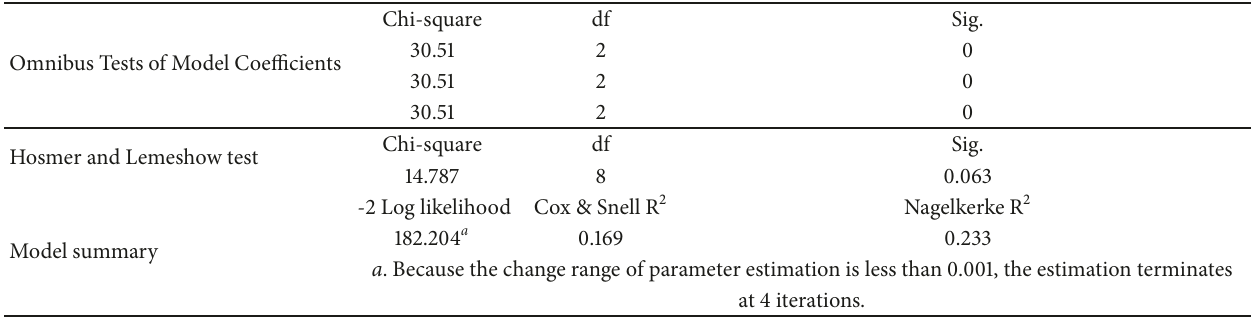
Table 3: Variables in the